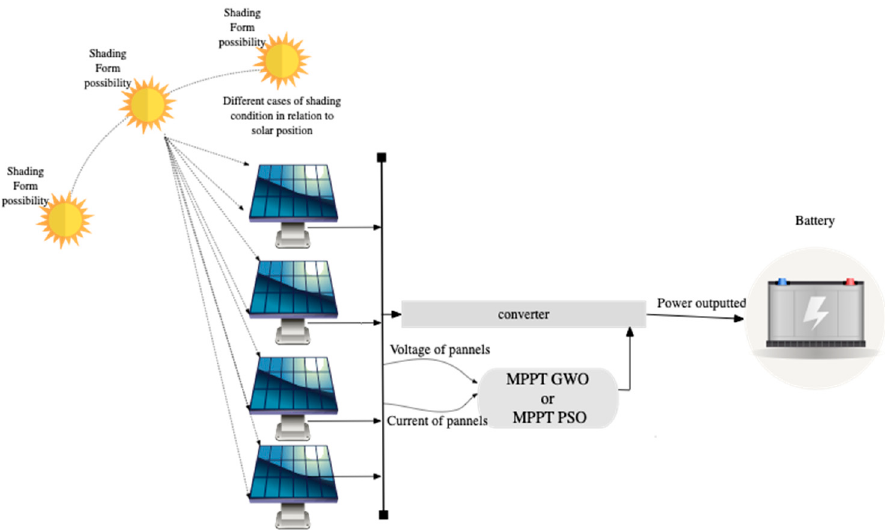
Figure 8. Overall system design in the simulation phase.